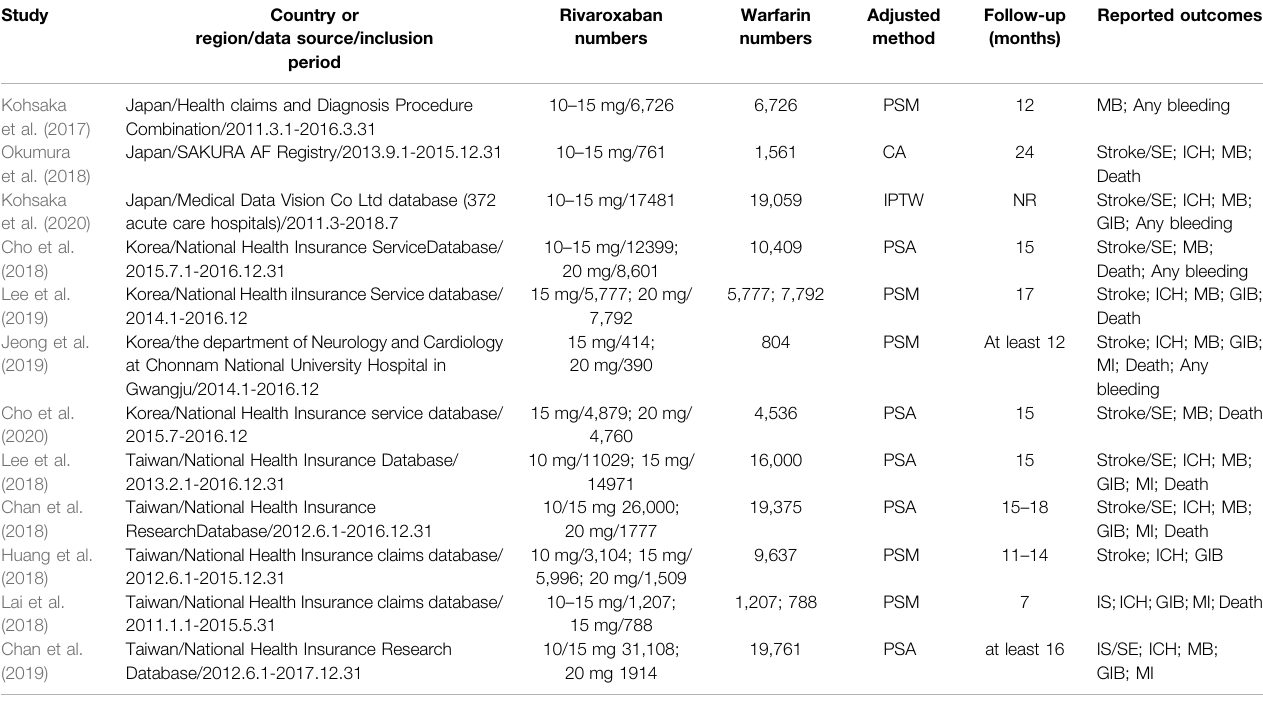
TABLE 1 | Characteristics of included studies.